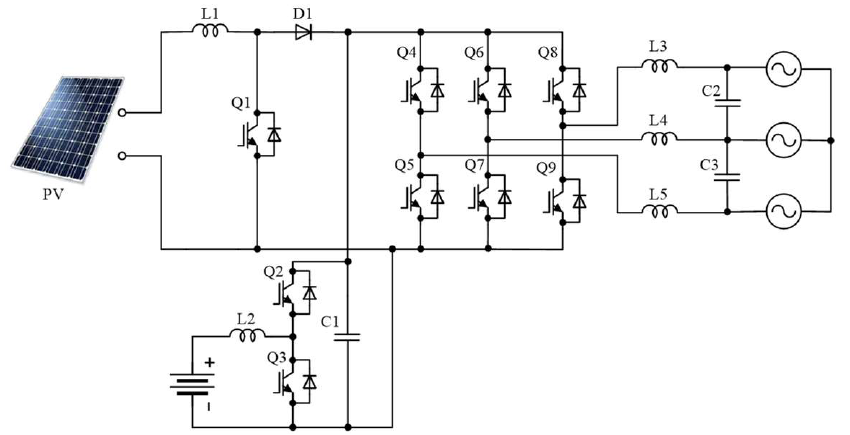
Figure 7. Dc bus MPC with boost-boost converters [49].